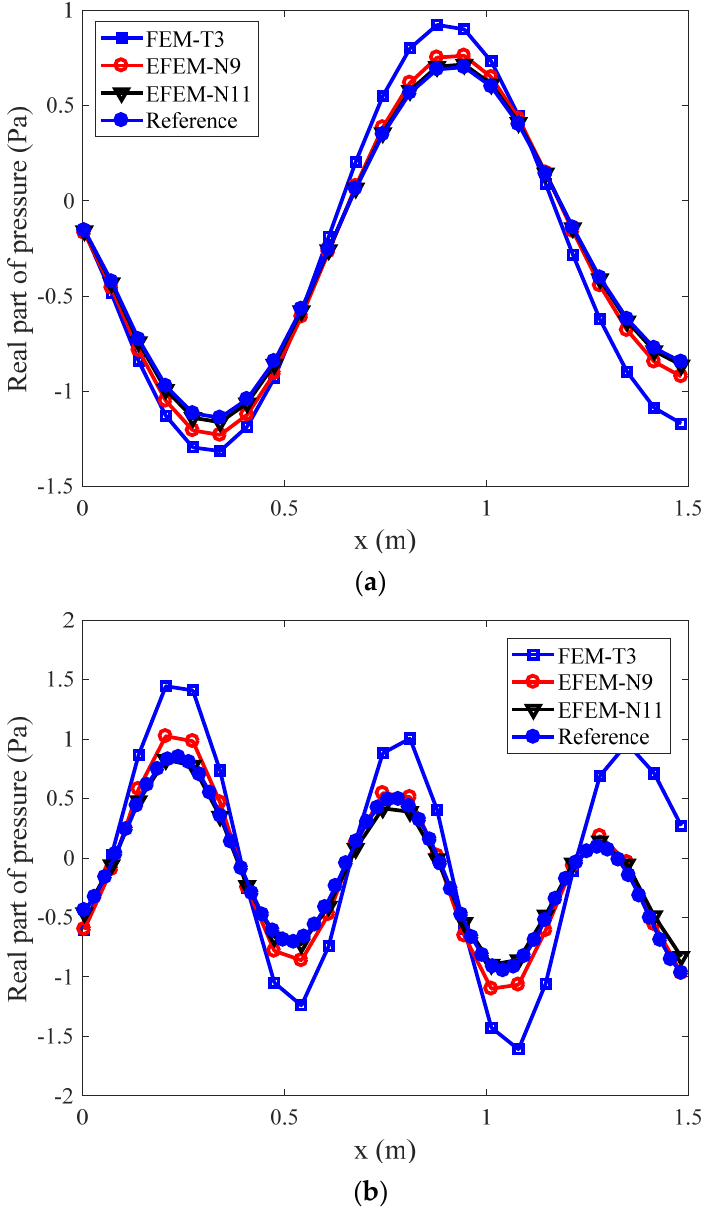
Figure 13. Comparisons the computed numerical acoustic pressure results along the defined path for two different frequency values: ( a ) the frequency value f = 320 Hz and ( b ) the frequency value f = 650 Hz.